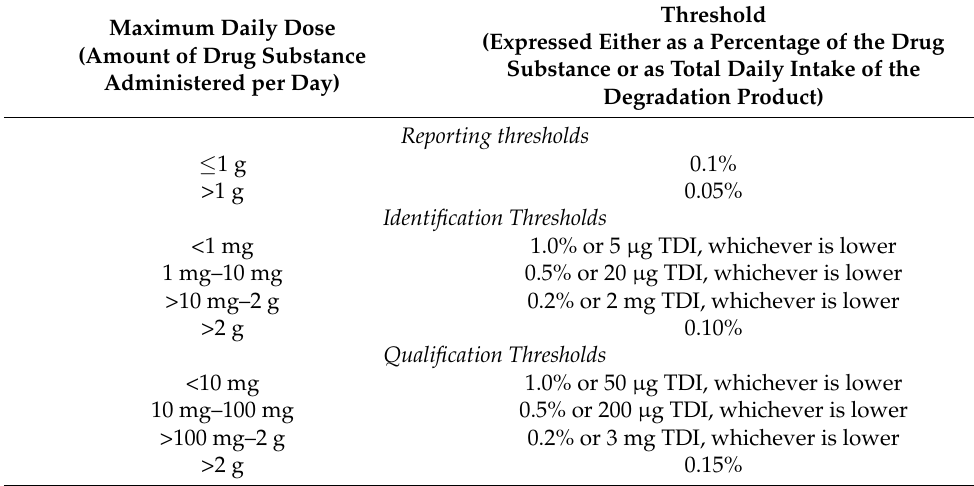
Threshold Substance or as Total Daily Intake of